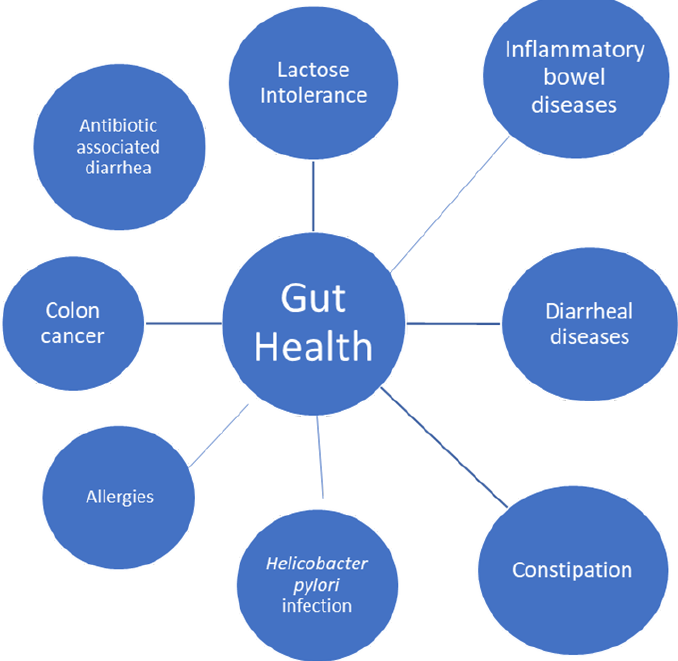
Figure 3. Effect of yoghurts and fermented milks on gut health.